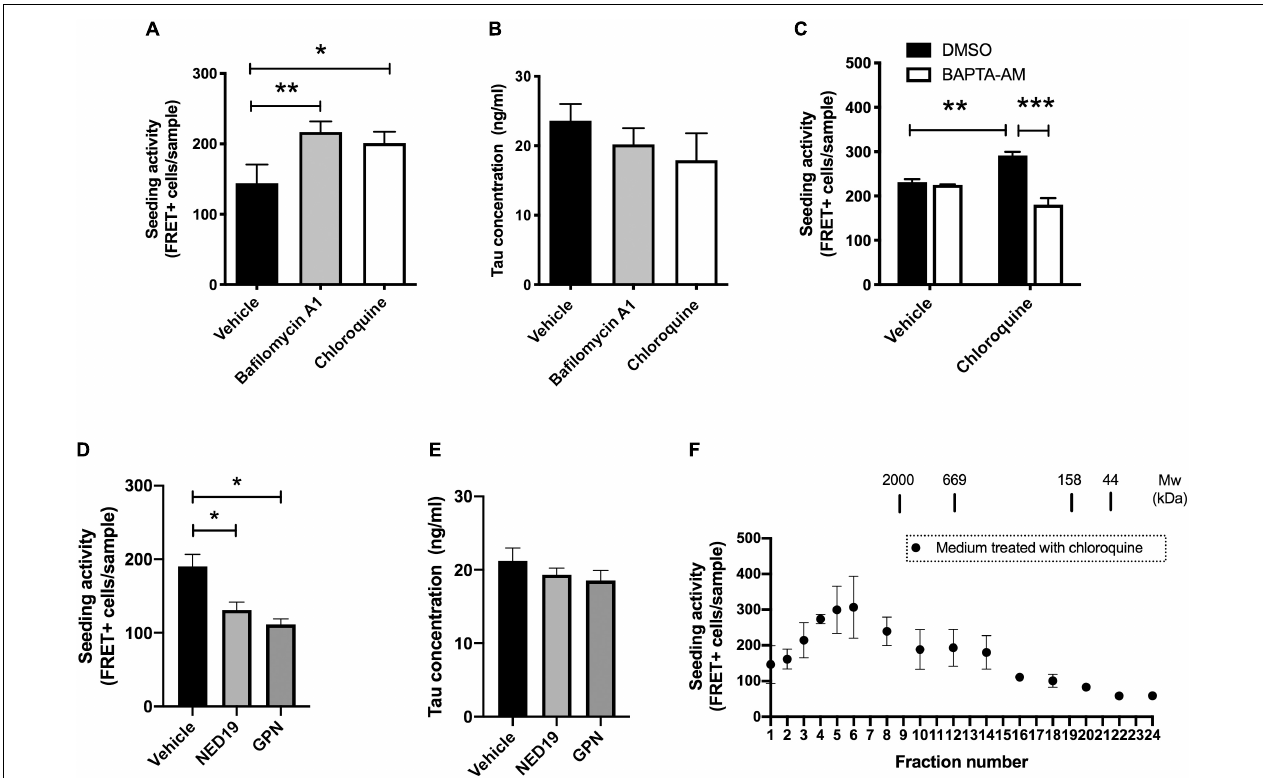
FIGURE 2 | Lysosomal stress increases the release of seed-competent tau. (A) Full-length tau expressing cells with RD transduction were treated with bafilomycin A1 (100 nM) or chloroquine (100 µ M) for 2 h. The seeding activities in the media were analyzed with biosensor cells. N = 3–6. ∗ p < 0.05, ∗∗ p < 0.01. (B) Tau concentration in media detected by Tau-5/BT2 ELISA was not altered by treatment with bafilomycin A1 or chloroquine. N = 3–6. (C) Pre-treatment with BAPTA-AM (20 µ M) for 30 min significantly inhibited the increase of FRET-positive biosensor cells by chloroquine. N = 3, ∗∗ p < 0.01, ∗∗∗ p < 0.001. (D) The addition of media from cells treated with GPN (200 µ M) or NED-19 (10 µ M) significantly decreased the number of FRET-positive biosensor cells. N = 3, ∗ p < 0.05. (E) Tau concentration in media detected by Tau-5/HJ8.7 ELISA was not altered by treatment with GPN or NED-19. N = 3. (F) Full-length tau expressing cells with RD transduction were treated with chloroquine for 2 h. The media were separated with a size-exclusion chromatography and analyzed with tau biosensor cells. N =